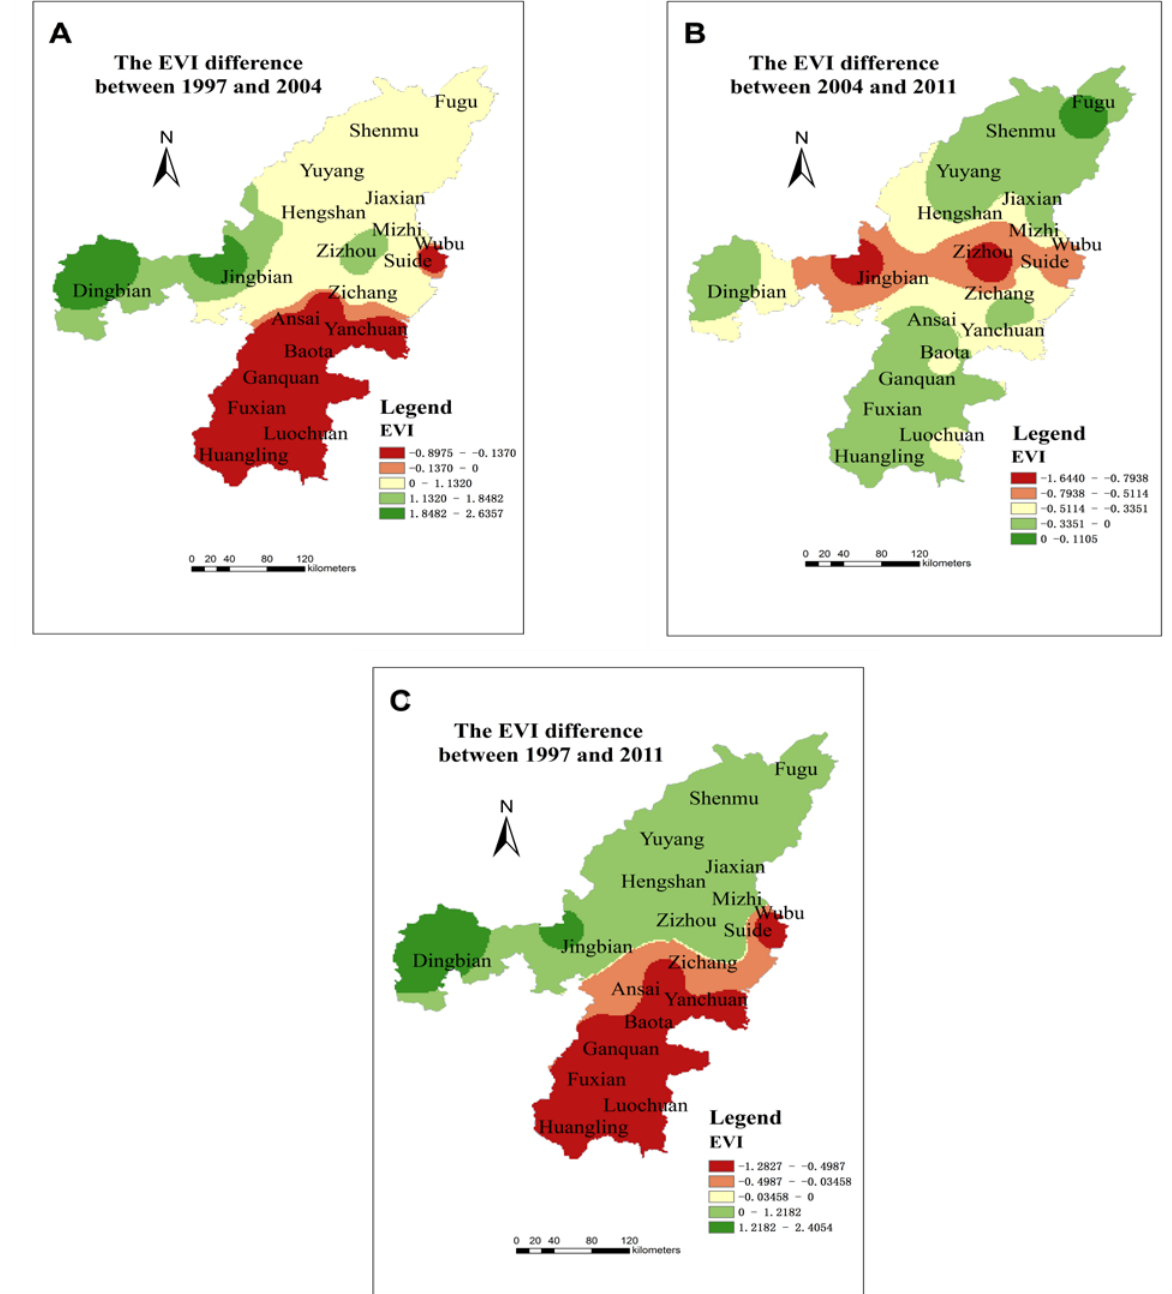
Figure 4. The changes in EVI difference between 1997 and 2004 ( A ); between 2004 and 2011 ( B ); between 1997 and 2011 ( C